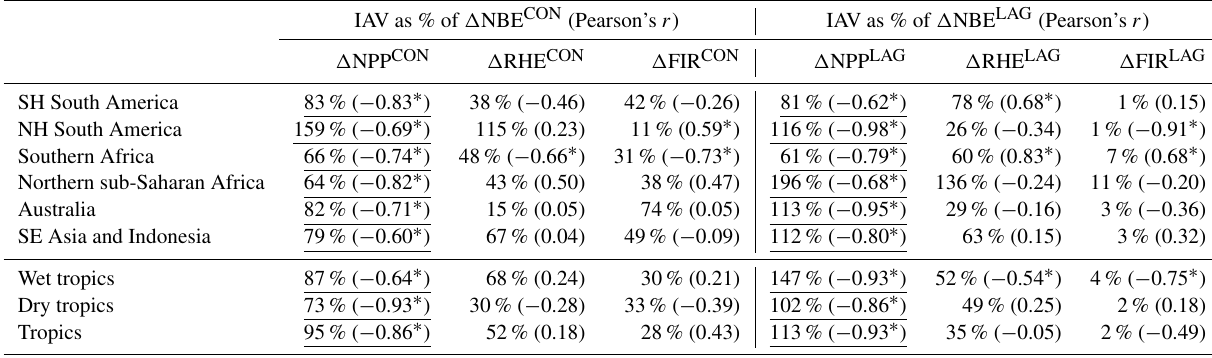
Table 4. Concurrent and lagged effect NBE attributed to constituent fluxes (net primary production, heterotrophic respiration and fires, abbreviated as NPP, RHE and FIR, respectively): IAV values are represented here as the ratio of constituent flux standard deviation to NBE standard deviations of annual 2001–2015 NBE values; bracketed values correspond to Pearson’s correlation coefficients between constituent flux and NBE (“ ∗ ” denotes p values<0.05). The underlined values denote the largest % IAV contribution to (cid:49) NBE CON and (cid:49) NBE LAG . IAV as % of (cid:49) NBE CON (Pearson’s r )